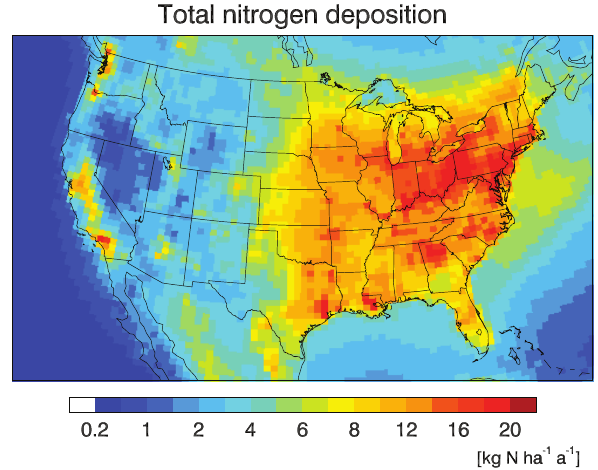
Table 4. Source contributions to nitrogen deposition over the